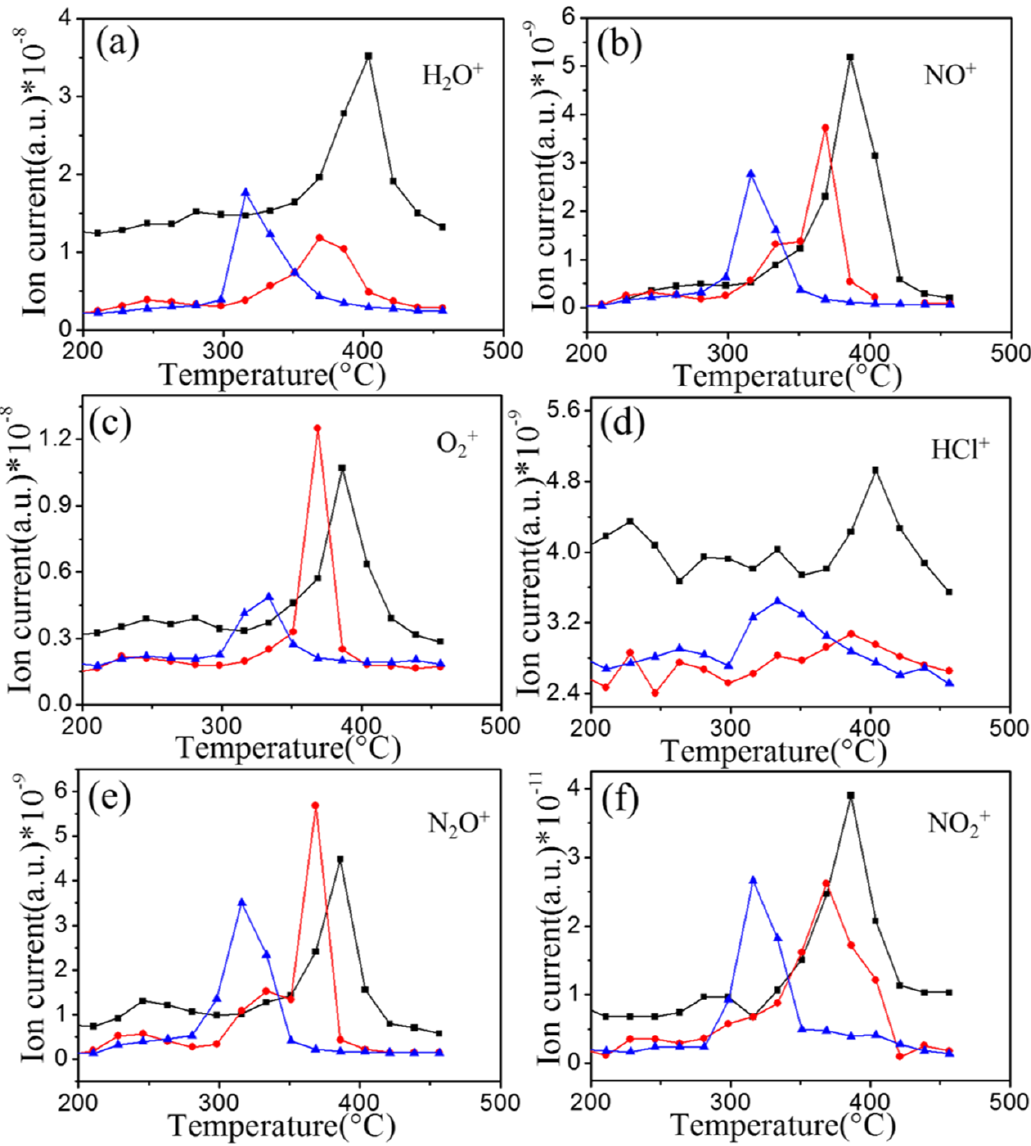
Figure 3. Ion intensity curves of ( a ) H 2 O + , ( b ) NO + , ( c ) O 2+ , ( d ) HCl + , ( e ) N 2 O + , and ( f ) NO 2+ . The black curves, red curves, and blue curves stand for decomposition products of pure AP, AP-10% Ti 2 CT x , and AP-30% Ti 2 CT x , respectively.